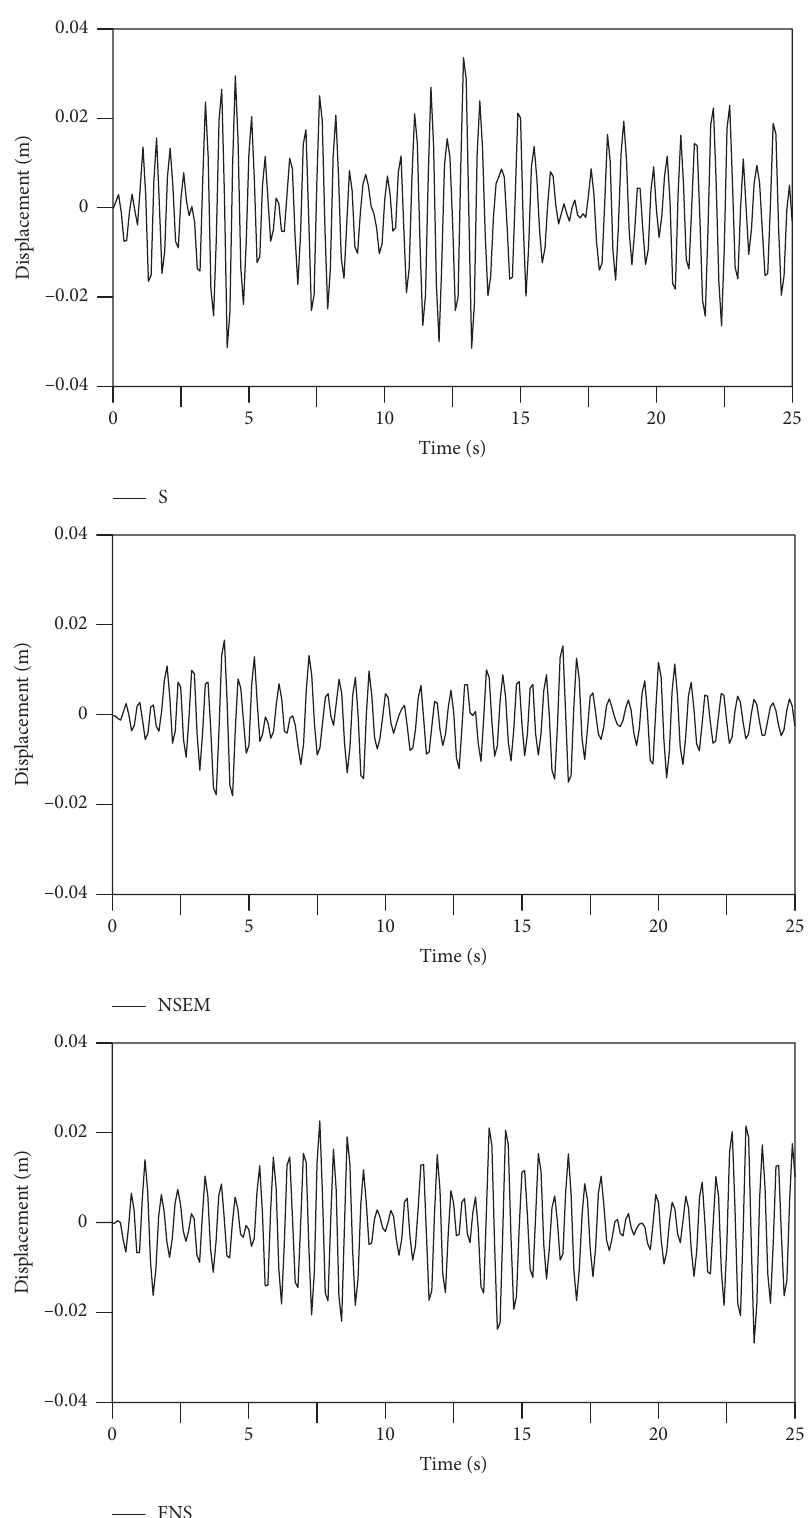
Figure 5: Model 1 response: first-floor displacement under input samples belonging to the set of the considered artificial